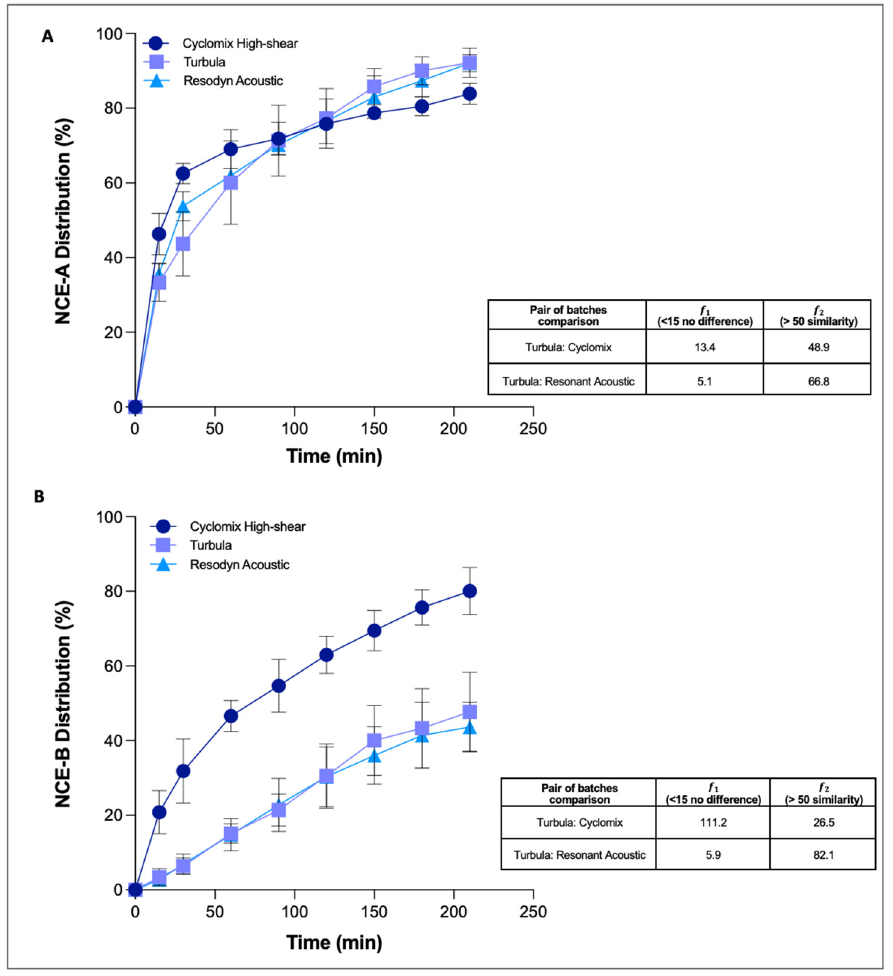
Figure 3. Cumulative mass (%) dissolution profiles of lactose blend formulations containing NCE-A (at 5% w / w ) ( A ) and NCE-B (at 4% w/w ) ( B ) after aerosolisation using RS01 inhaler ( n = 3, mean ± SD). Difference ( 𝑓 1) and similarity factor ( 𝑓 2) were calculated taking the batches mixed using Turbula as a reference.